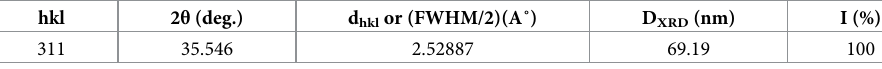
Table 1. The obtained structural parameters of XRD analysis. The average crystallite size D of the particles is calcu- lated from the Scherrer equation: D = K λ /( β cos θ ),where K is the Debye-Scherrer constant (0.89), λ is the X-ray wave- length (1.54 nm), β is the peak width of half-maximum (FWHM/2 = 2.5288 Å ), and θ is the Bragg diffraction angle. Breifly, β × 3.1416/180 ! 2.52887 × 3.1416 /180 ! 0.0441; 2 Theta = 35.546 ! θ = 17.773; Cos θ = 0.474363; D = K λ / (